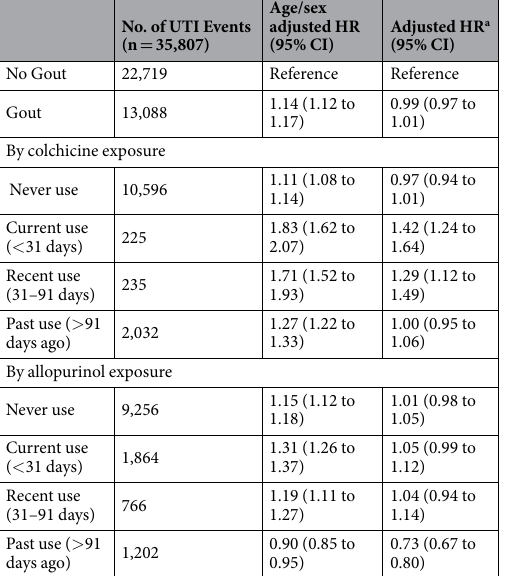
No. of UTI Events (n = 35,807)